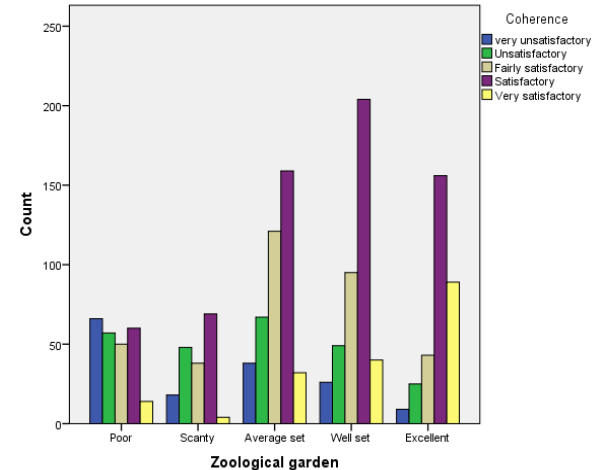
Figure 7. Influence of satisfaction with coherence on the perception of quality of Zoological gardens in Federal Universities in the South-west Nigeria